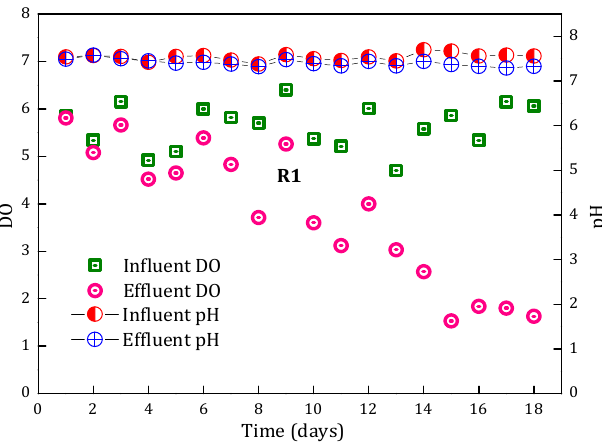
Figure 5. The variation of pH and dissolved oxygen (DO) in filter R1 during the start-up period.